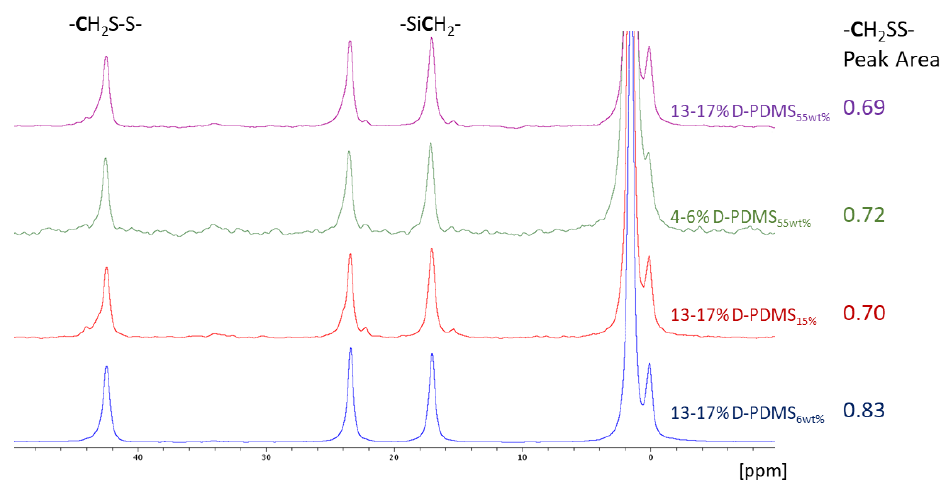
Figure 4. Solid state CP/MAS 13 C NMR spectra of solid D-PDMS materials with - C H 2 SS- peak areas. The areas of the - C H 2 SS- peaks (42.4 ppm) were normalized with respect to the -Si C H 2 - peaks (17.1 ppm), which were set to 1C in each spectrum.